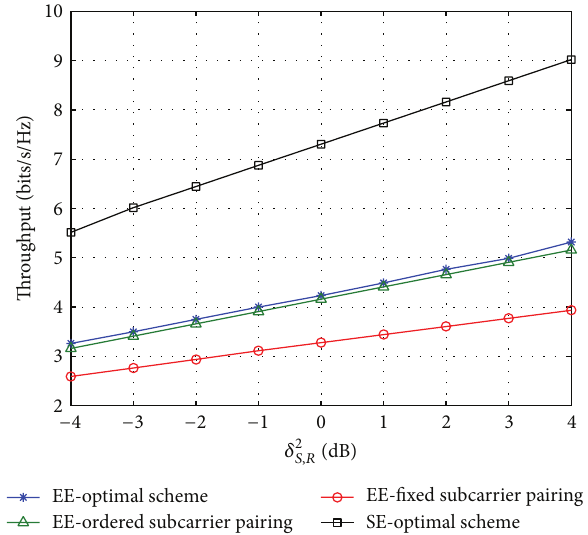
Figure 3: Energy efficiency versus channel variance of 𝑆 → 𝑅 link with 𝑁 = 2 relays, and 𝑤 1 = 1 , 𝑤 2 = 2 .